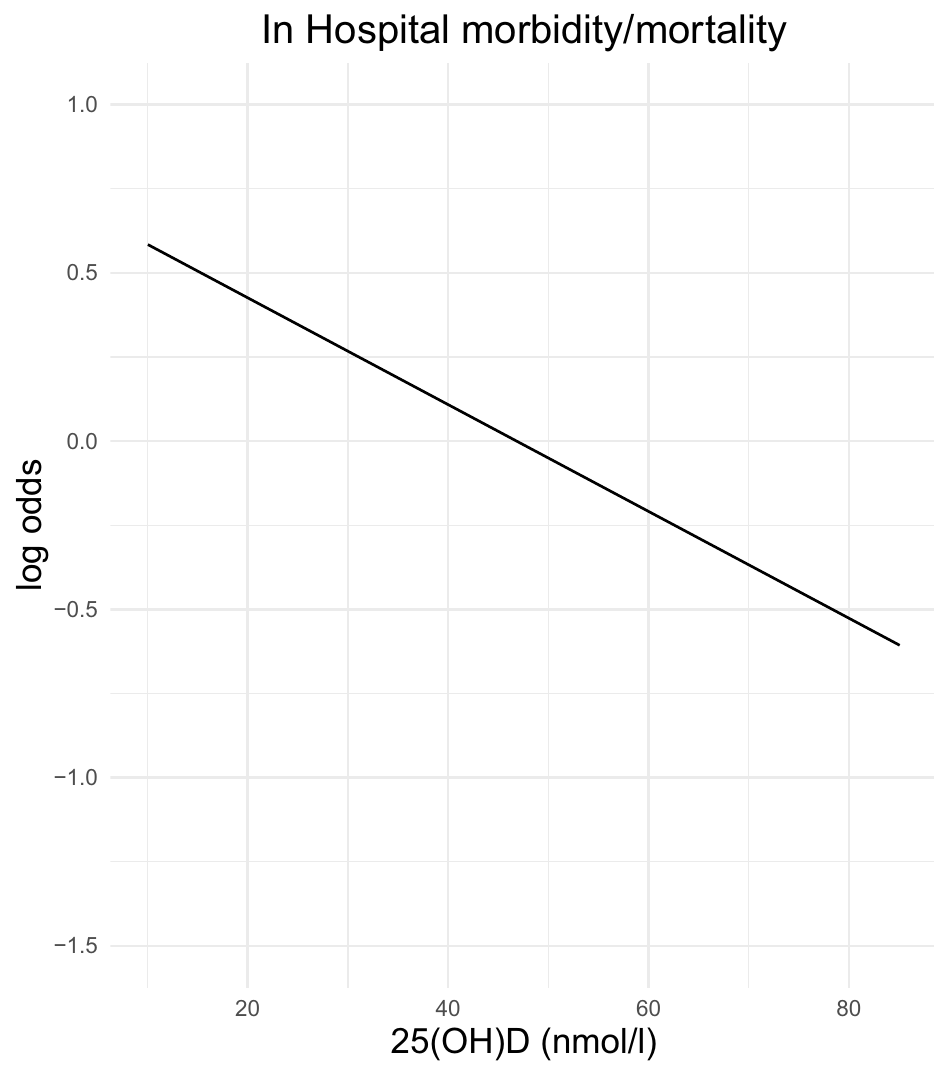
Fig 1. Risk of in-hospital morbidity/mortality (in log odds) versus vitamin D concentration. This figure depicts the risk in-hospital morbidity/mortality (log odds) as a function of vitamin D concentration. We observed that the log odds value decreases as vitamin D concentration increases. Probabilities were estimated using a logistic regression